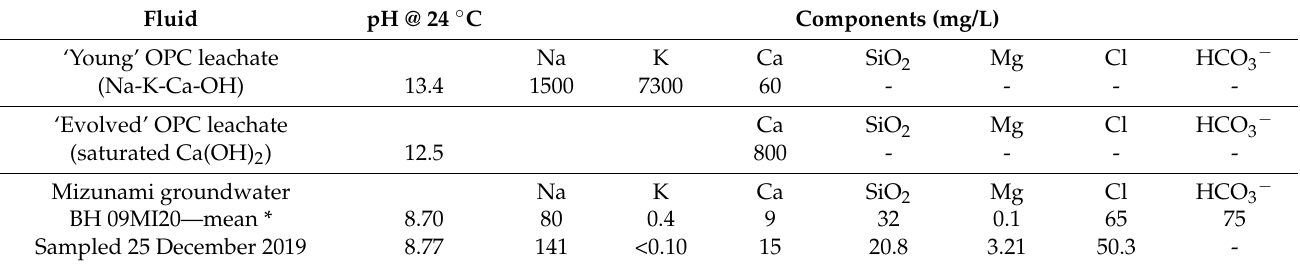
Table 1. Initial concentrations of major ions in the OPC leachates and Mizunami groundwater.